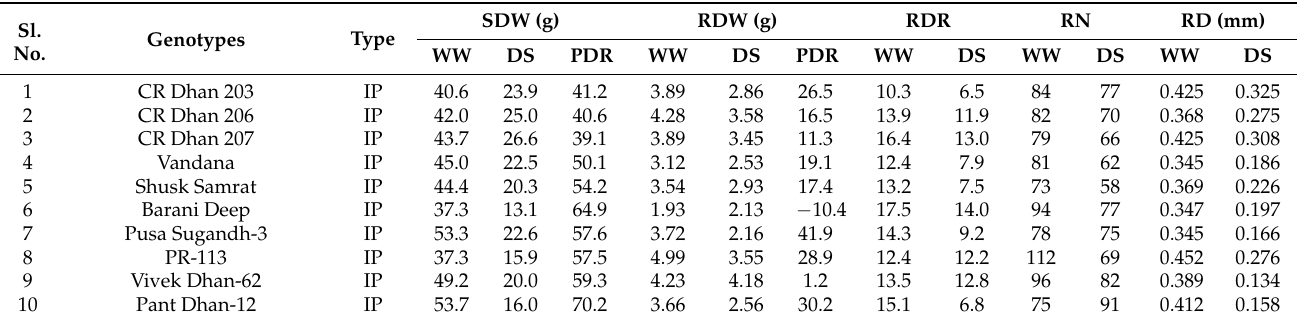
Figure 1. Soil moisture tension ( A ) and soil moisture content ( B ) measured by tensiometer and time-domain reflectometer, respectively, at soil depths of 30 and 45 cm. Values shown are mean ± SE, n = 3. DAS = days after stress. Table 2. Variation in root and shoot parameters under well-watered and drought stress conditions in 49 rice